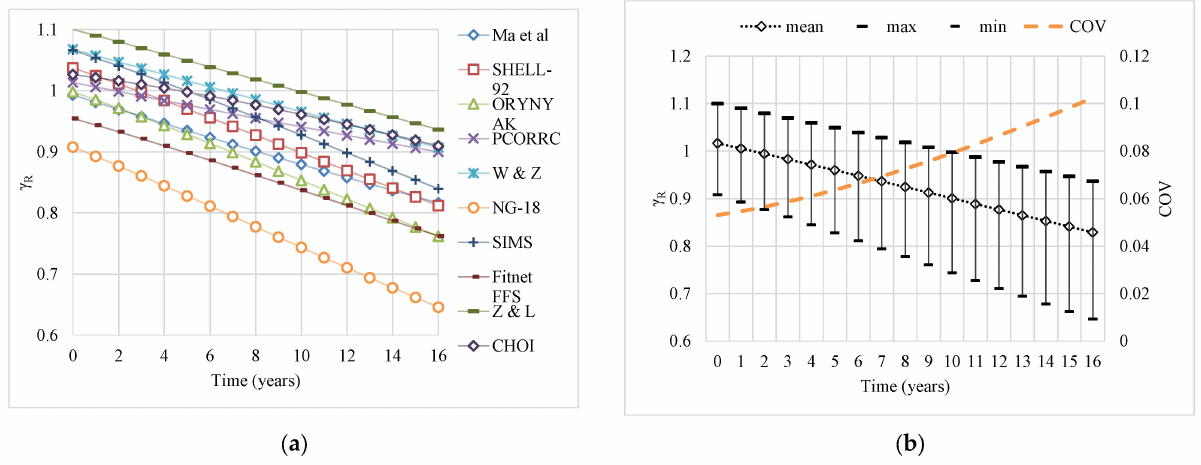
Figure 5. ( a ) PSF ( γ R ) for high-grade steel as a function of elapsed life and ( b ) mean, range and uncertainty of PSF.